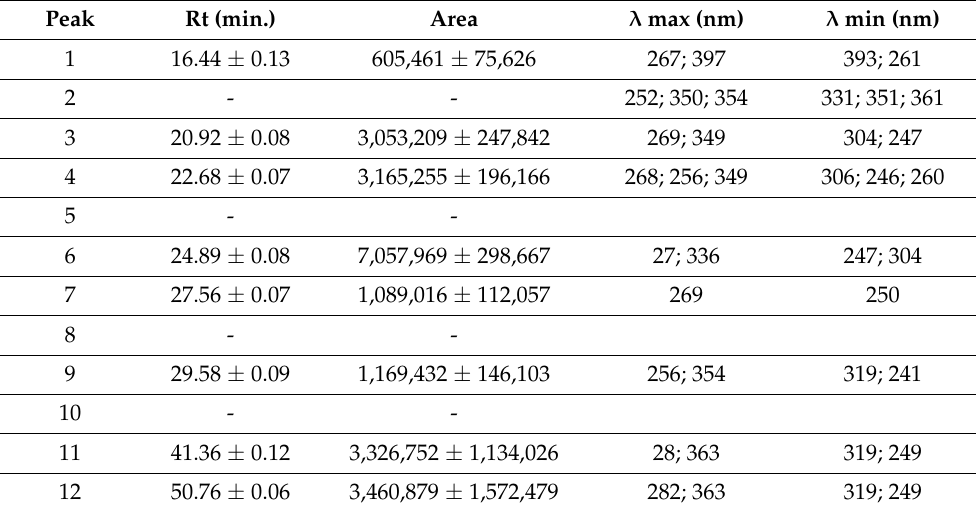
Table 1. Peak characteristics of M. chamissois Naudin aqueous extract from leaves (AEMC) analyzed by HPLC/DAD at 354